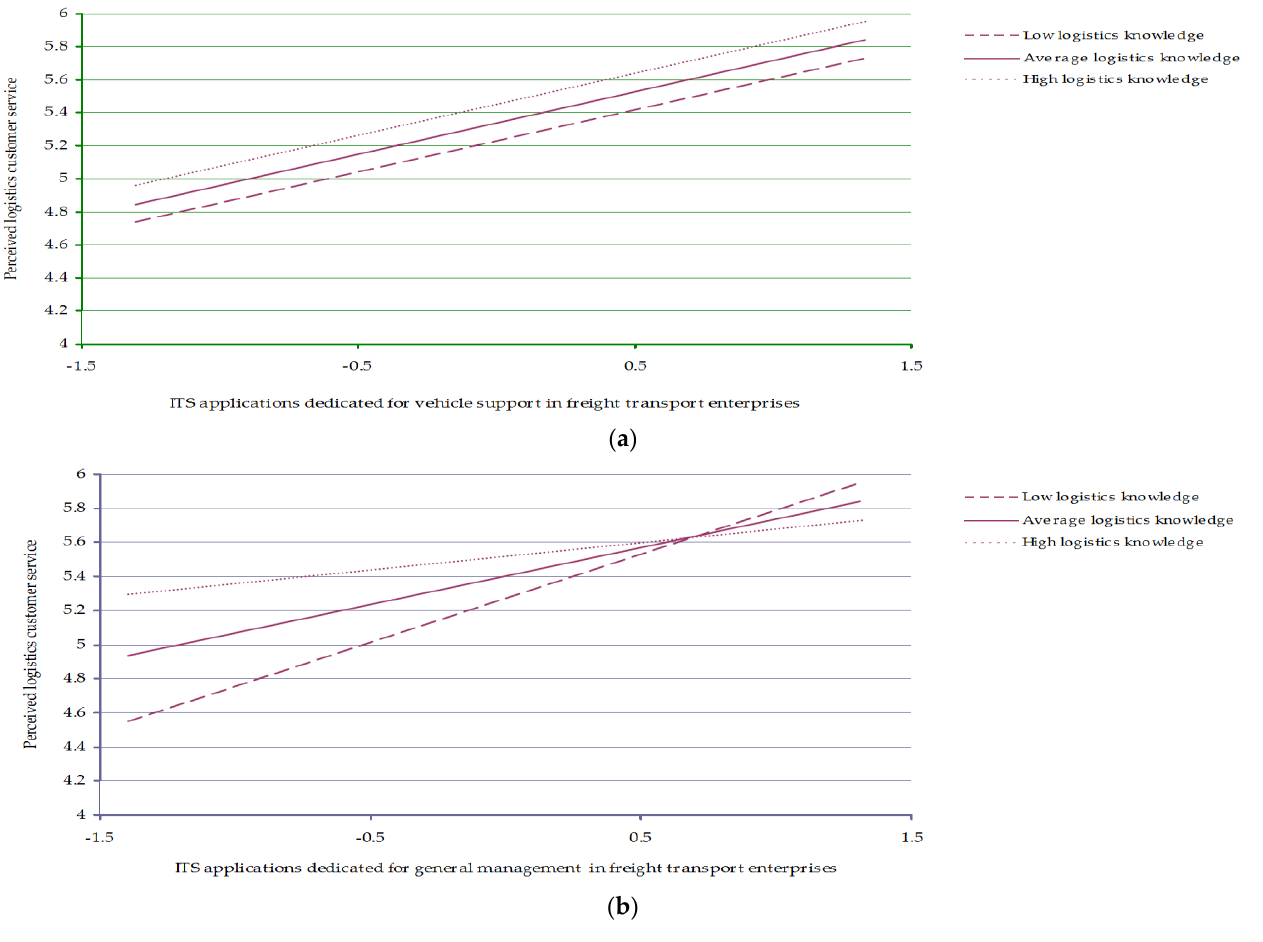
Figure 5. Moderating effect of logistics knowledge for: ( a ) ITS applications dedicated to vehicle support in road freight transport enterprises, ( b ) ITS applications dedicated to general management in road freight transport enterprises.